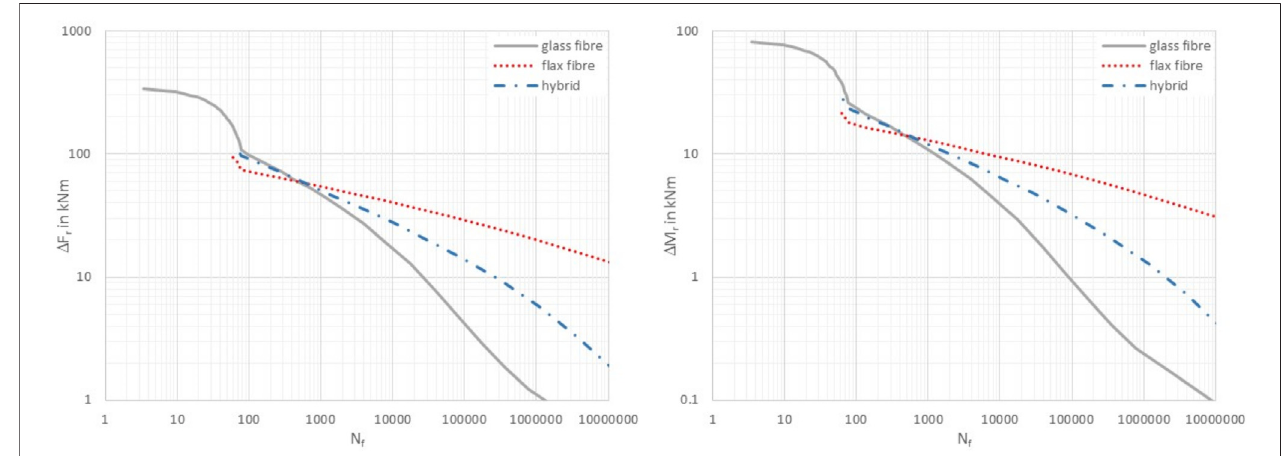
FIGURE 14 | Component related S − N − curve for the axle